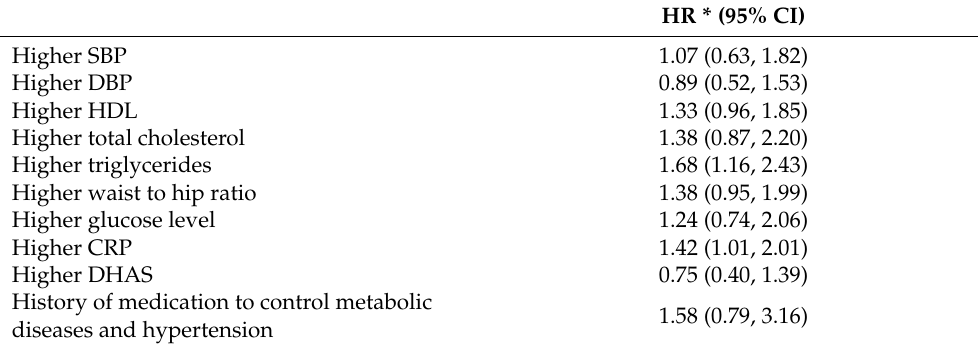
Table 5. Association between individual biomarkers of AL scores and overall cancer